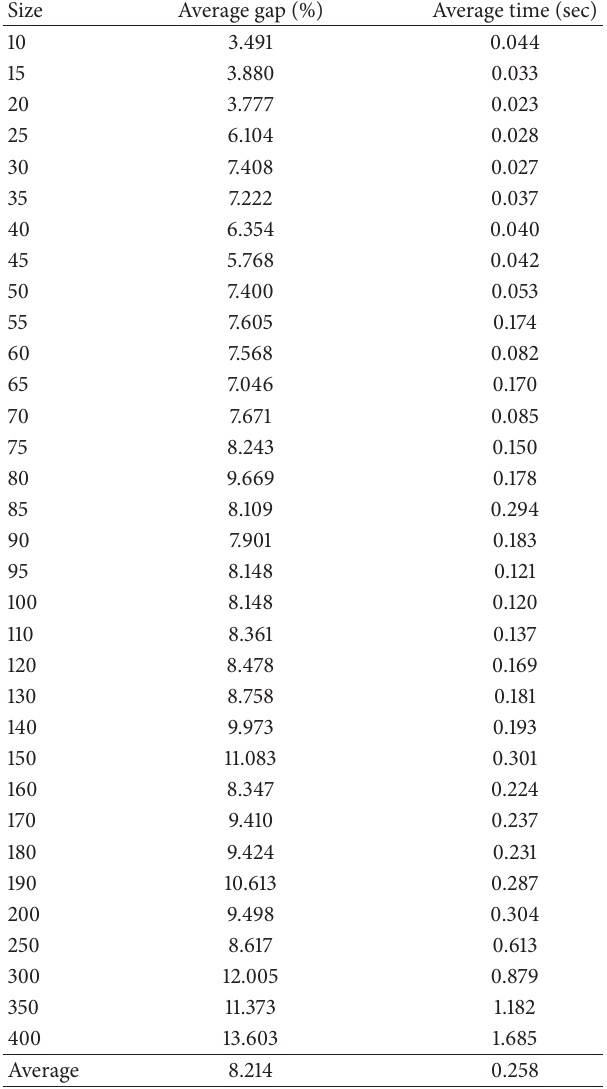
Table 2: Results of the greedy correction